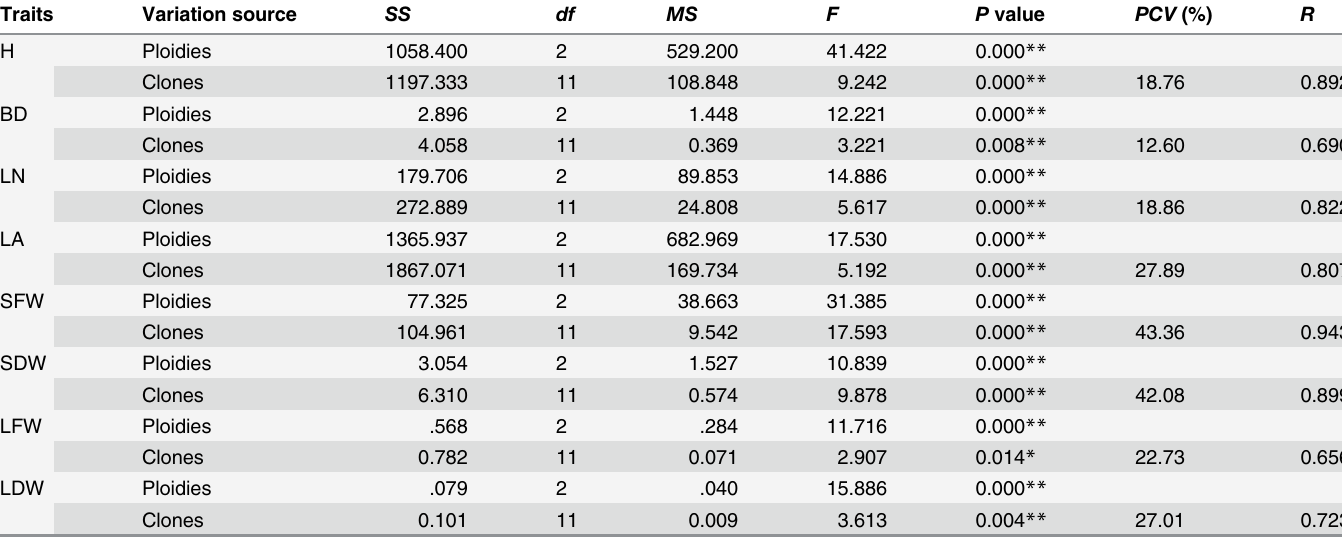
Table 1. ANOVA analyses, PCV and R of different traits among different ploidies and clones.